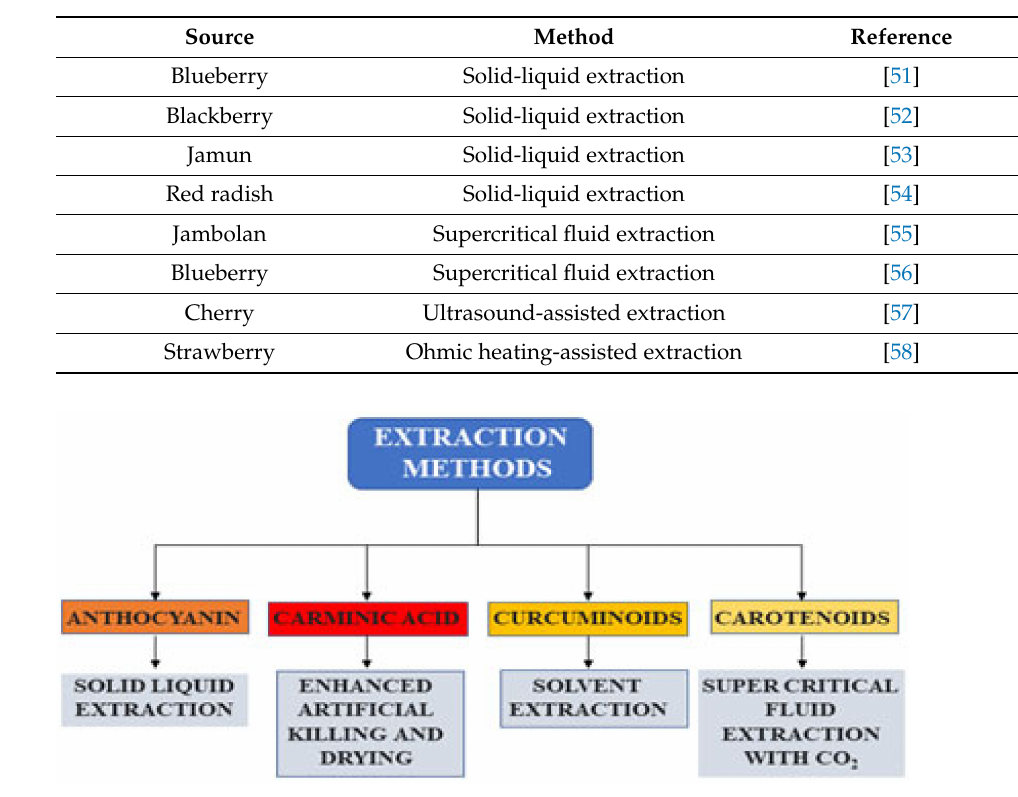
Figure 4. Extraction methods for the recovery of natural